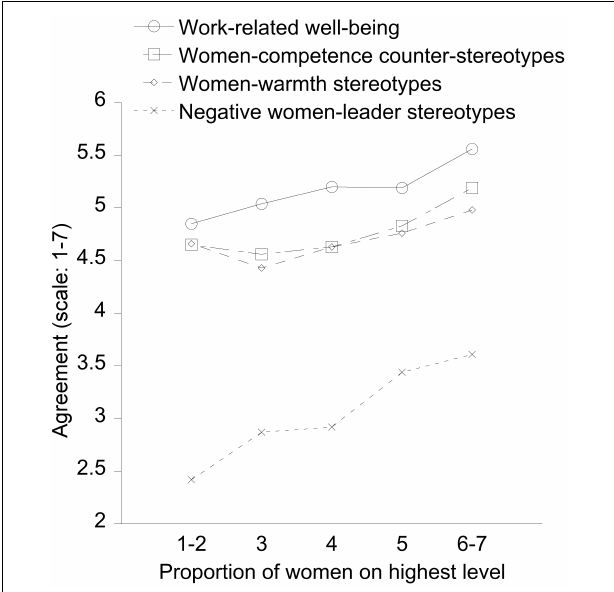
FIGURE 1 | Degree to which women in leadership positions (both on the highest and intermediate level), depending on the proportion of female leaders on the highest level in their organization (scale: 1–2 – almost only men, to 6–7 – almost only women), reported high work-related well-being, and endorsed positive women-competence counterstereotypes and women-warmth stereotypes, as well as negative stereotypes of women as leaders. All variables show linear trends, with increasing agreement (1 = “do not agree at all” to 7 = “completely agree”) going along with increasing proportions of women